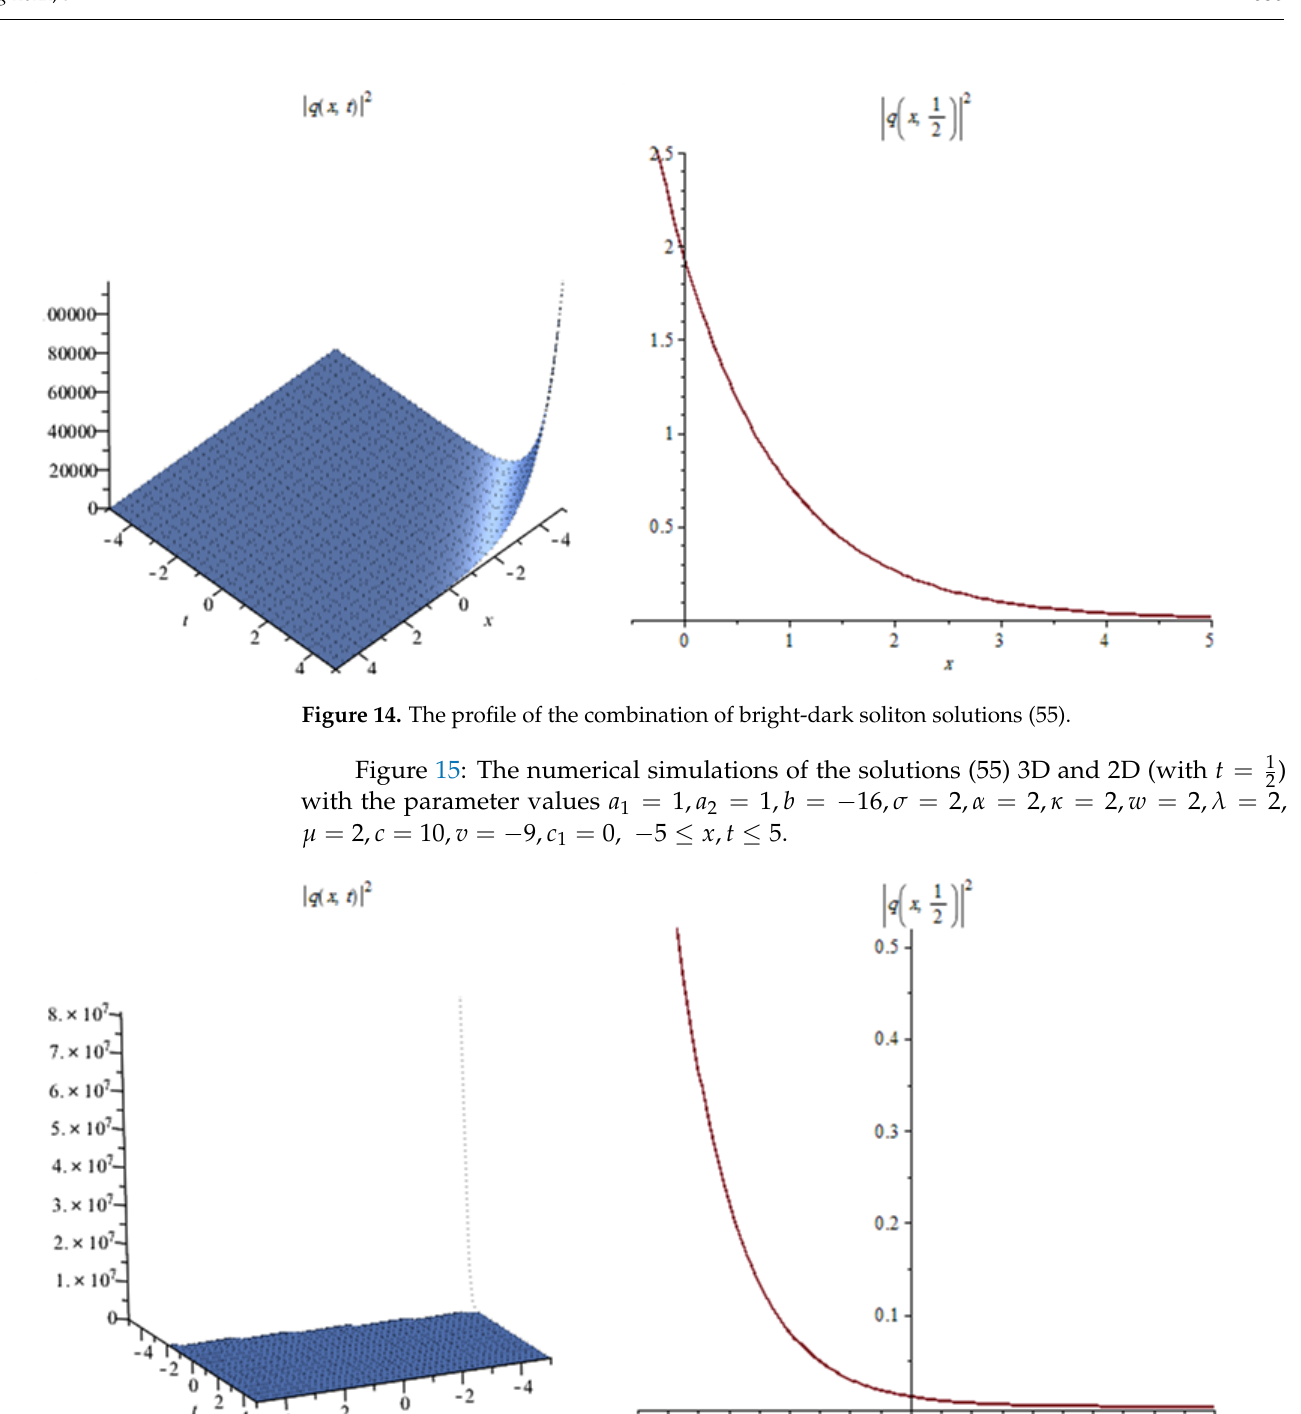
Figure 15. The profile of the combination of bright-dark soliton solutions